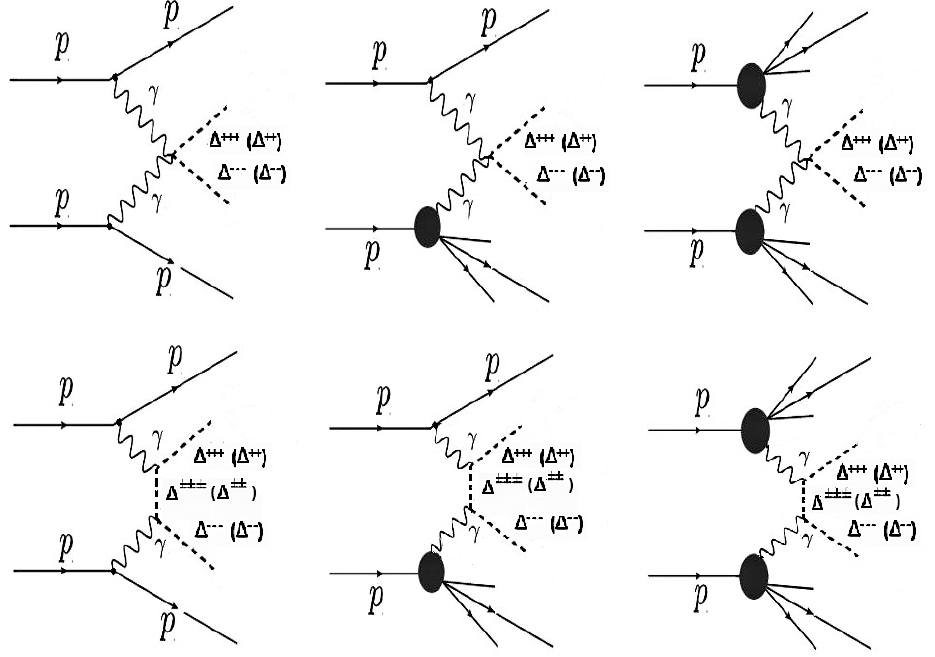
Figure 5 . Feynman diagrams for the pair production of (cid:1) (cid:6)(cid:6)(cid:6) and (cid:1) (cid:6)(cid:6) via photon-photon fusion processes. Left panel: elastic, middle panel: semi-elastic and Right panel: inelastic scattering